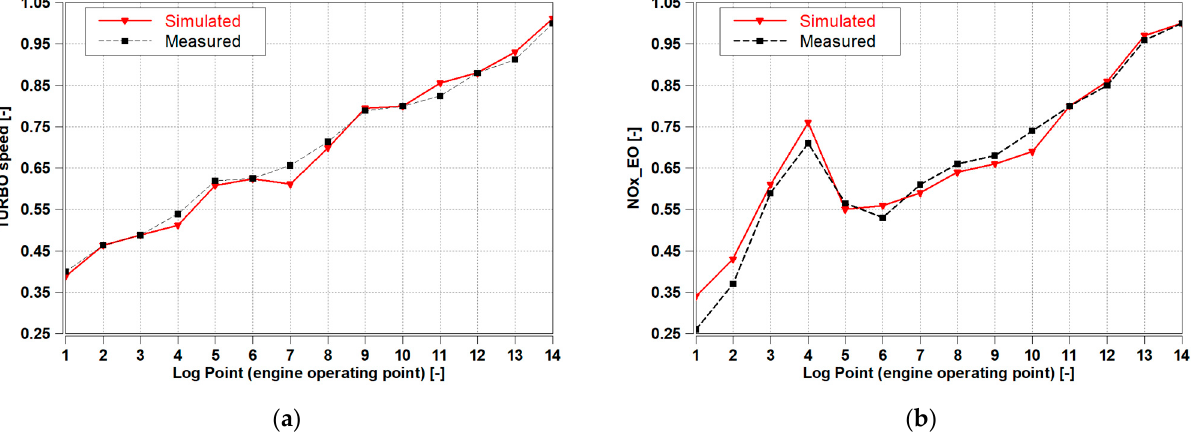
Figure 23. ( a ) Simulated (red) vs. measured (black) turbocharger speed (normalized with respect to the maximum value reached in the test); ( b ) Simulated (red) vs. measured (black) NOx engine out emission (normalized with respect to the maximum value reached in the test).